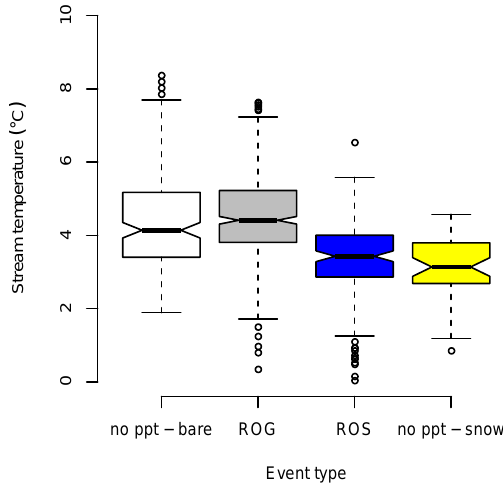
Fig. 10. Daily mean stream temperature at East Creek as a function of air temperature, classified into five event types: (1) rain on bare ground, (2) no precipitation with bare ground, (3) snowing, (4) no precipitation with snow cover, and (5) rain on snow.